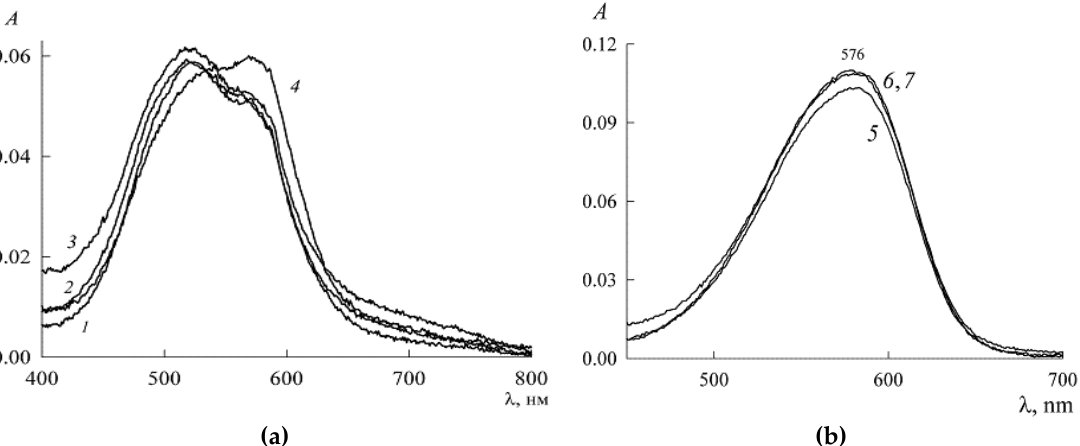
Figure 11. Absorption spectra of SDS solutions in the presence of NR ( c 2 = 3.03 µ M) at values of c 1 , mM: ( a ) 2.2 (1), 2.8 (2), 5.5 (3), and 7.5 (4); ( b ) 9.1 (5), 10 (6), and 10.5 (7). Optical path length l = 1 cm.